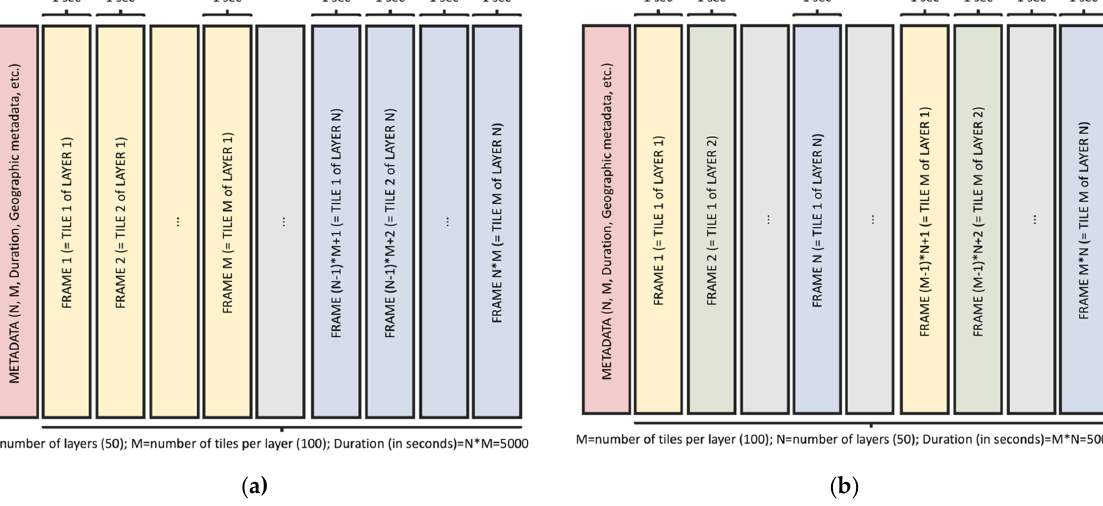
Figure 4. Schematics of two different internal tiling modes in CORE ( a ) layer contiguous (LC) ( b ) tile contiguous (TC).